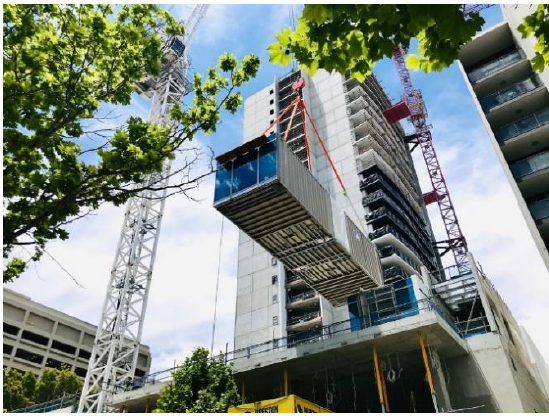
Figure 5. Module installation at site (photo by Y. Sun).